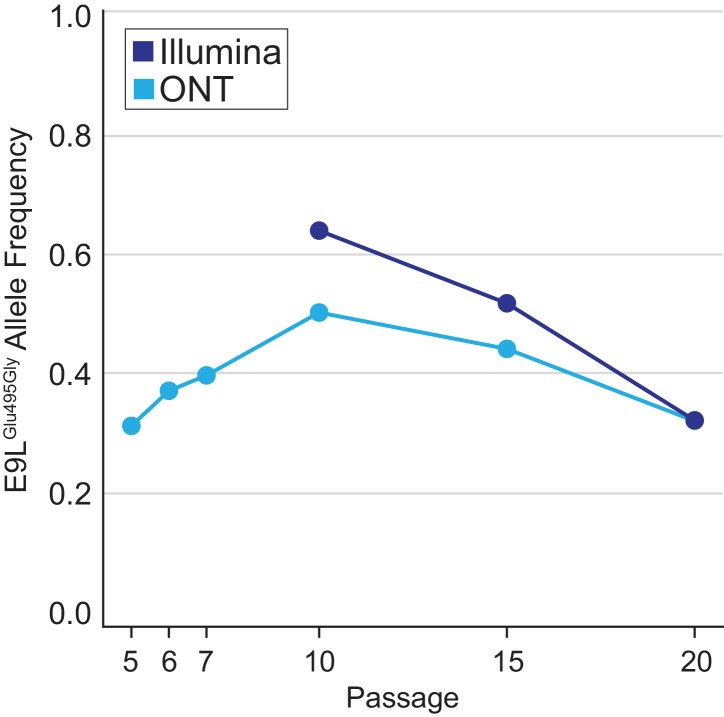
E9LGlu495Gly variant dynamics.Population-level E9LGlu495Gly allele frequencies were estimated using freebayes and nanopolish on Illumina or ONT reads, respectively, from different passages as in Figure 2B.10.7554/eLife.35453.019Figure 2—figure supplement 1—source data 1.Data used to generate Figure 2—figure supplement 1.